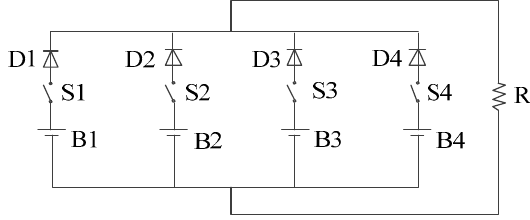
Figure 3. Battery redundancy module. Figure 3. Ba tt ery redundancy module.